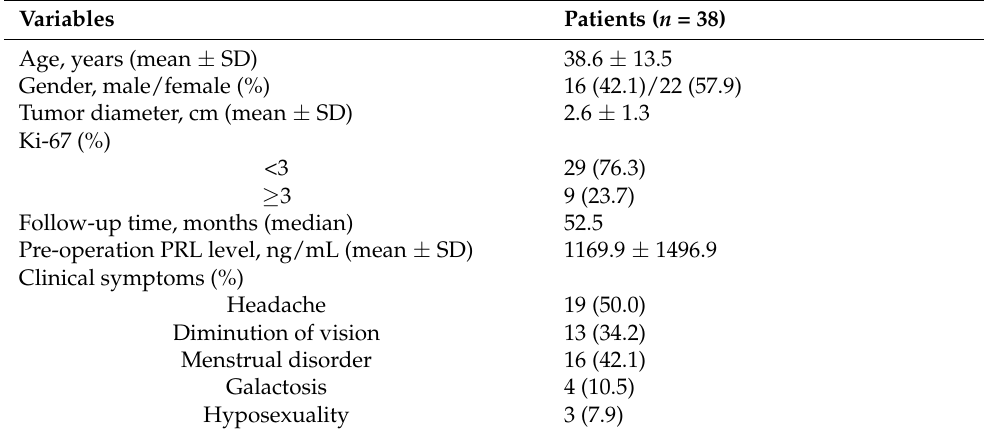
Table 1. Baseline characteristics of 38 patients with surgically treated cystic pituitary prolactin- secreting